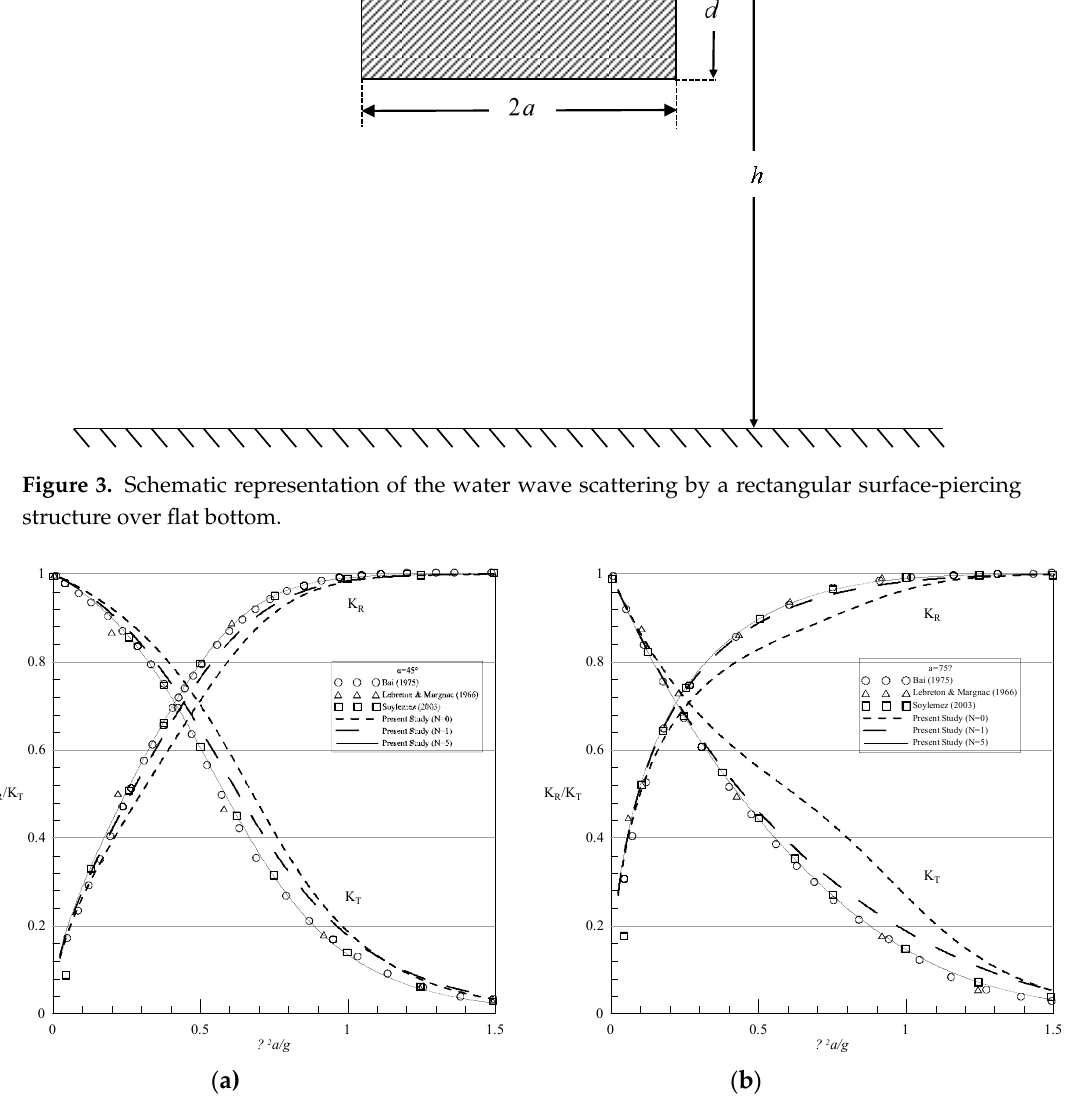
Figure 4. Comparison of the reflection and transmission coefficients from the present study with the results in the literatures for water wave scattering by a rectangular surface-piercing structure over flat bottom with incidence angles ( a ) α = 45 o and ( b ) α = 75 o .